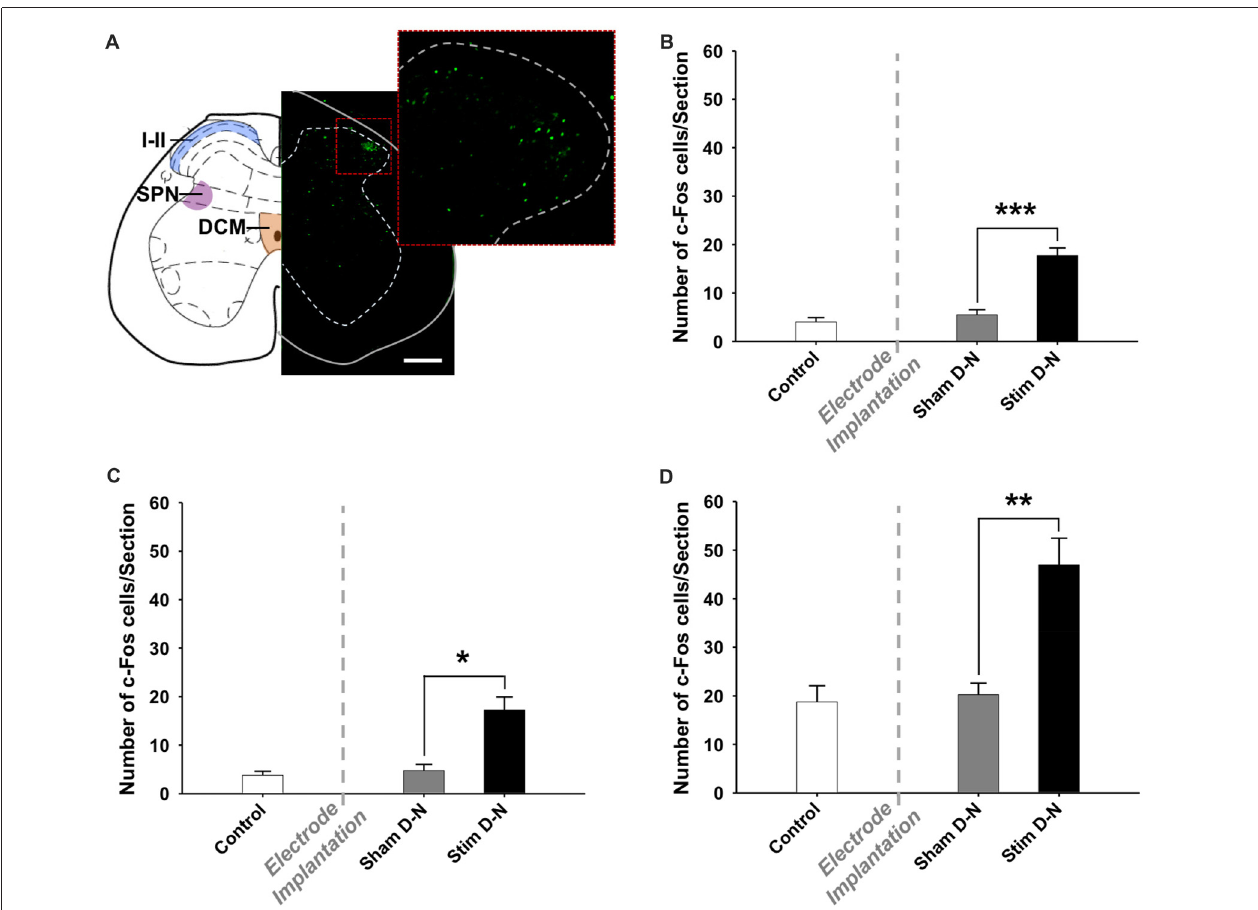
FIGURE 8 | Expression of cFos immunoreactive cells in the lumbosacral spinal cord. (A) Coronal diagram of the rat lumbosacral spinal cord (L6) showing the location of the dorsal horn (i.e., laminae I and II), the sacral parasympathetic nucleus and the dorsal commissure (Rat brain atlas, Paxinos and Watson, 2007) and a corresponding photomicrograph showing a spinal cord section stained for cFos of stimulated rat with bipolar stimulation electrode implanted in the bladder wall in the D-N configuration. The higher power photomicrograph in the right corner shows the dorsal horn of the spinal cord. Abbreviations: I–II: laminae I and II, DCM: dorsal commissure, SPN: sacral parasympathetic nucleus. Scale bar = 200 µ m. Cumulative data showing the means and SEM for the optical density of cFos expression for D-N group in the (B) SPN, (C) DCM and (D) I–II of L6-S2 spinal cord. Control n = 4, Sham D-N n = 4 and Stim D-N n = 4. t -test, ∗ p < 0.05, ∗∗ p < 0.005 and ∗∗∗ p <